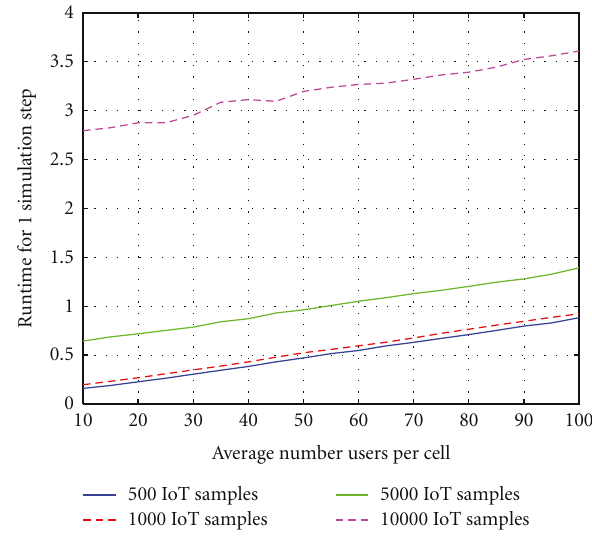
Figure 11: SINR distribution in overloaded cell no.11 with and without LAPC.